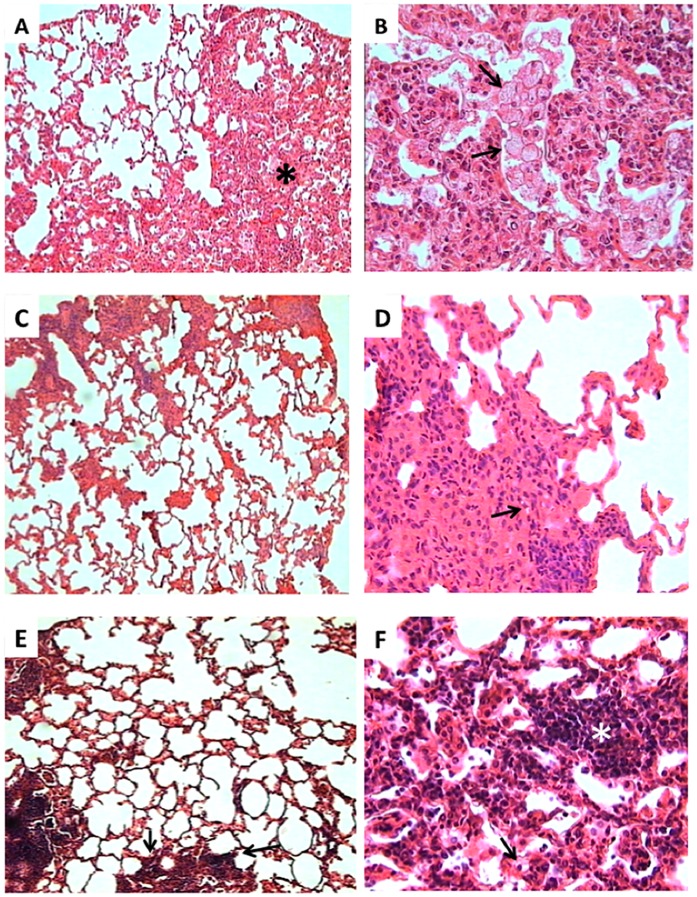
Representative lung histopathology of control non-treated and treated mice during 30 days with IDR-HH2 or IDR-1018.(A) Low power micrograph from a control mouse showing extensive pneumonic areas (asterisk) (H/E, 25x). (B) High power magnification from the same pneumonic area in control mouse showed numerous vacuolated macrophages (arrows) (H/E, 400x). (C) In contrast, the lung of mouse treated with IDR-HH2 exhibited a lesser pneumonic area (H/E, 25x). (D) High power micrograph from the pneumonic area of mouse treated with IDR-HH2 show numerous large activated macrophages with abundant and compact cytoplasm and occasional foamy macrophages (arrow) (H/E, 400x). (E) The lungs of mice treated with IDR-1018 exhibited mild pneumonia, and abundant perivascular inflammatory infiltrate, predominantly constituted by lymphocytes (arrows) (H/E, 25x). (F) High power magnification of the pneumonic area in a mouse treated with IDR-1018 showed numerous activated macrophages, occasional vacuolated macrophages (arrows) and abundant lymphocytes around blood vessels (white asterisk) (H/E, 400x). Micrographs are representative of three experiments with an n = 6.